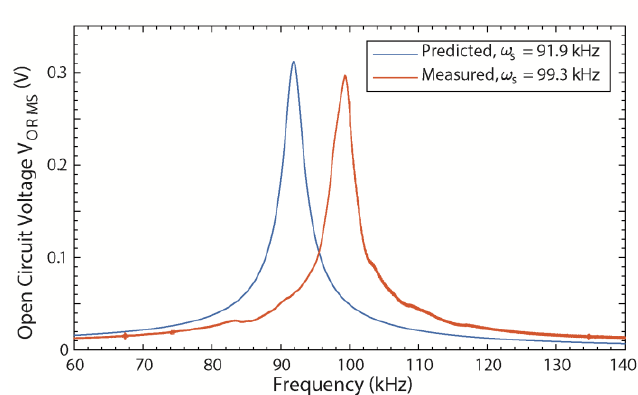
Figure 11. Metglas-PVDF open circuit voltage vs. frequency.